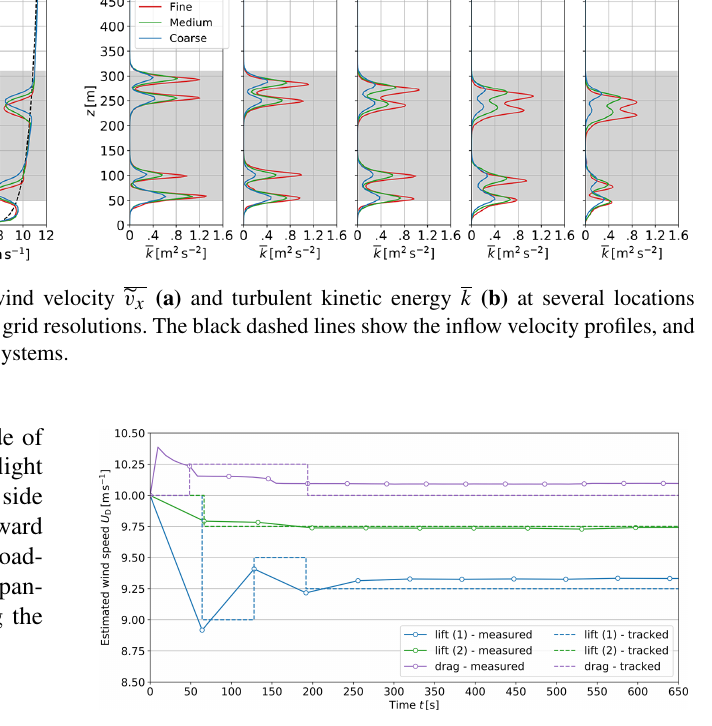
Figure A7. Convergence of the controller supervision level for the three types of AWE systems investigated. The markers display the time-averaged wind speed value sampled during one (lift mode) and five (drag mode) periodic cycles, and the dashed lines show the as- sociated reference wind speed of the tracked trajectories in incre- ments of 0.25ms − 1